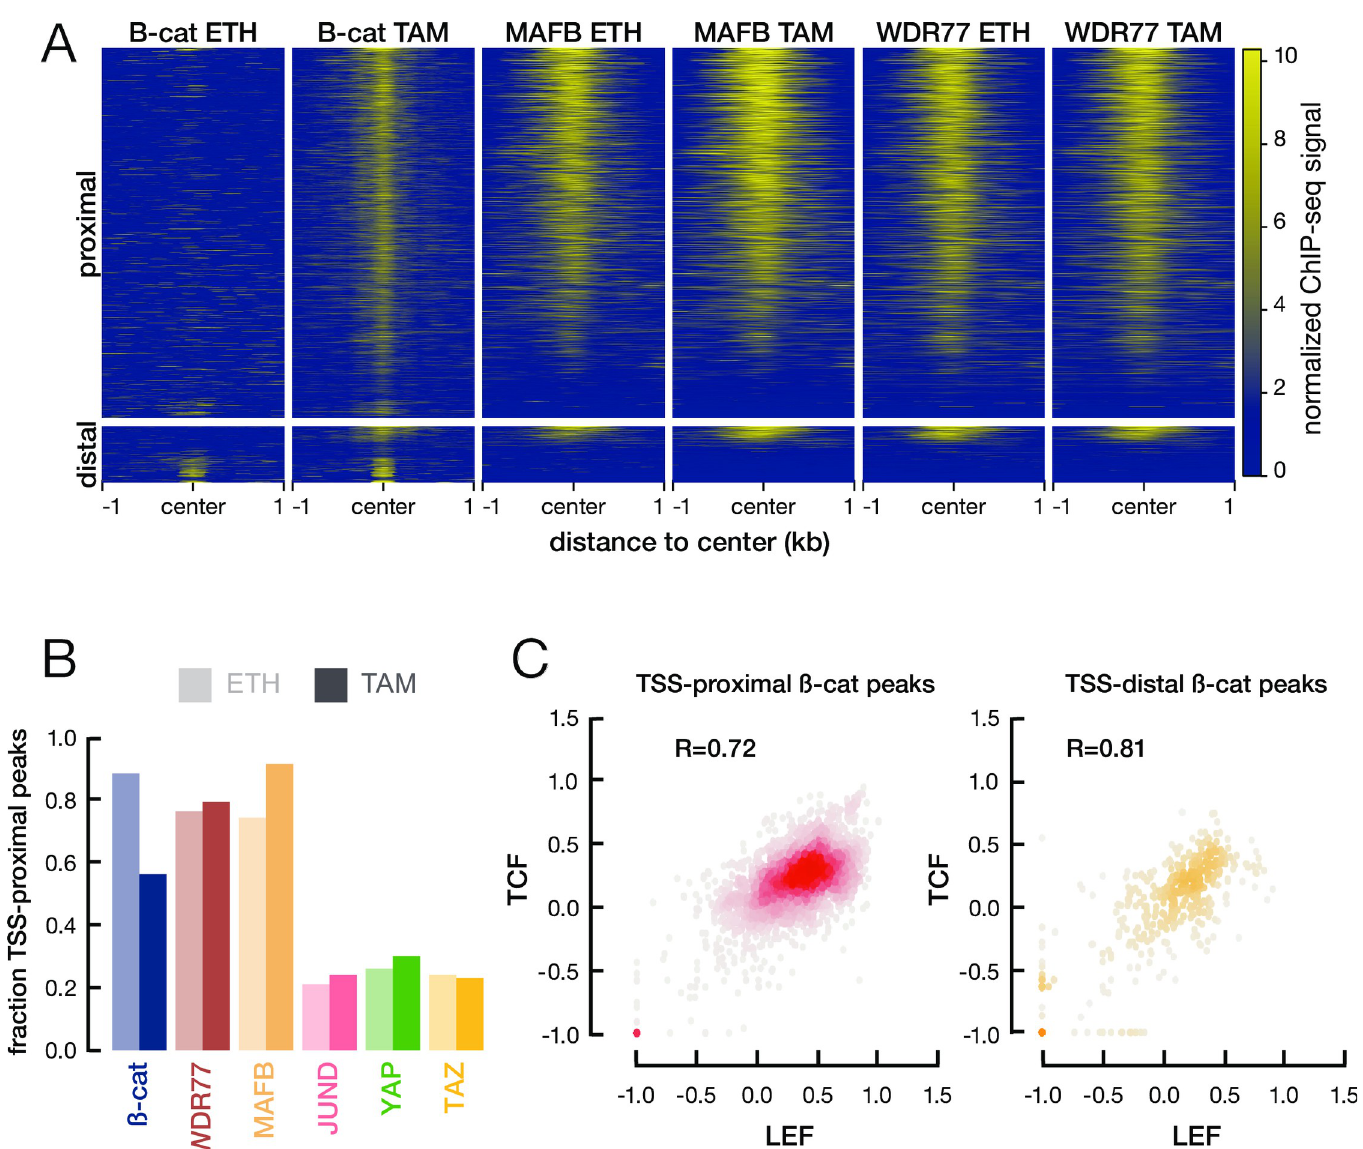
Fig 3. Similar genome association profiles of ß-catenin, MafB, and WDR77. (A) Heatmap of ChIP-seq signals of the indicated proteins in tamoxifen- (TAM) or ethanol (ETH)-treated cells. Each row of the heatmap corresponds to a genomic region bound by ß-catenin in transformed cells, with rows sorted by the average ChIP-seq signal across six experiments. TSS-proximal and TSS-distal peaks are shown separately. (B) Percentage of ChIP-seq peaks of the indicated proteins that are TSS proximal. (C) Correlation of TCF and LEF ChIP-seq signals at TSS-proximal and TSS-distal peaks of ß-catenin in transformed cells-TAM peaks. Pearson correlation coefficients are